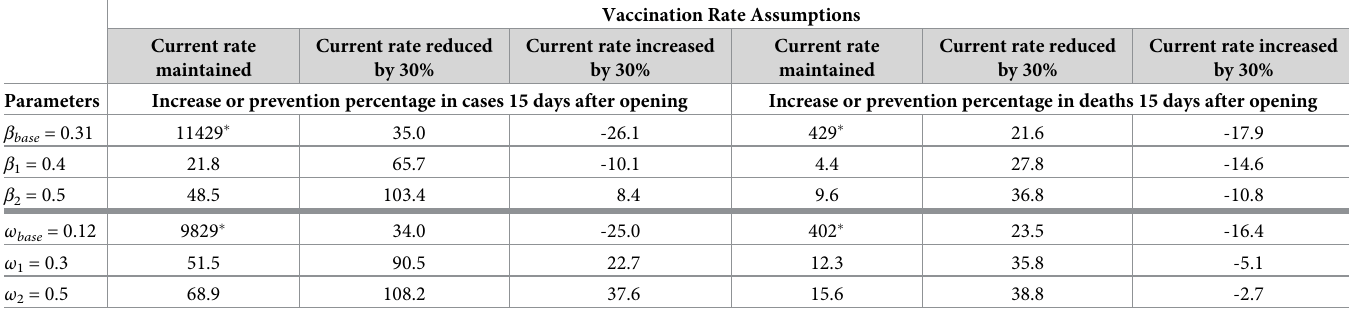
Table 3. Parameters values for the baseline scenario correspond to the posterior median value β base = 0.31, ω base = 0.12, λ v 1 = 0.00598, λ v 2 = 0.032; β = 0.4, 0.5, and ω = 0.3, 0.5 were selected according to historical data in CA (see S6 Fig in S1